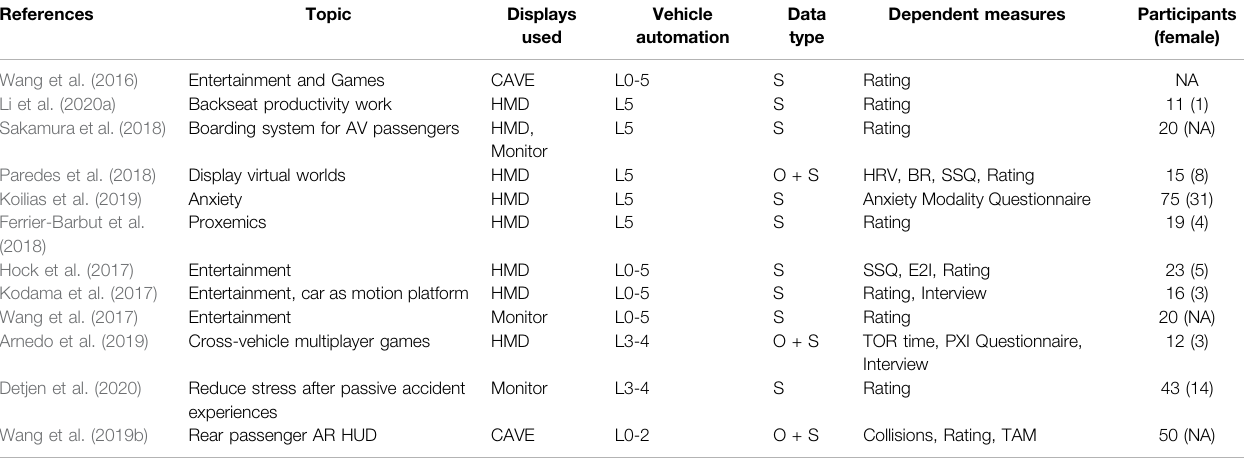
TABLE 8 | Summary of user studies in Passenger Experiences application area.